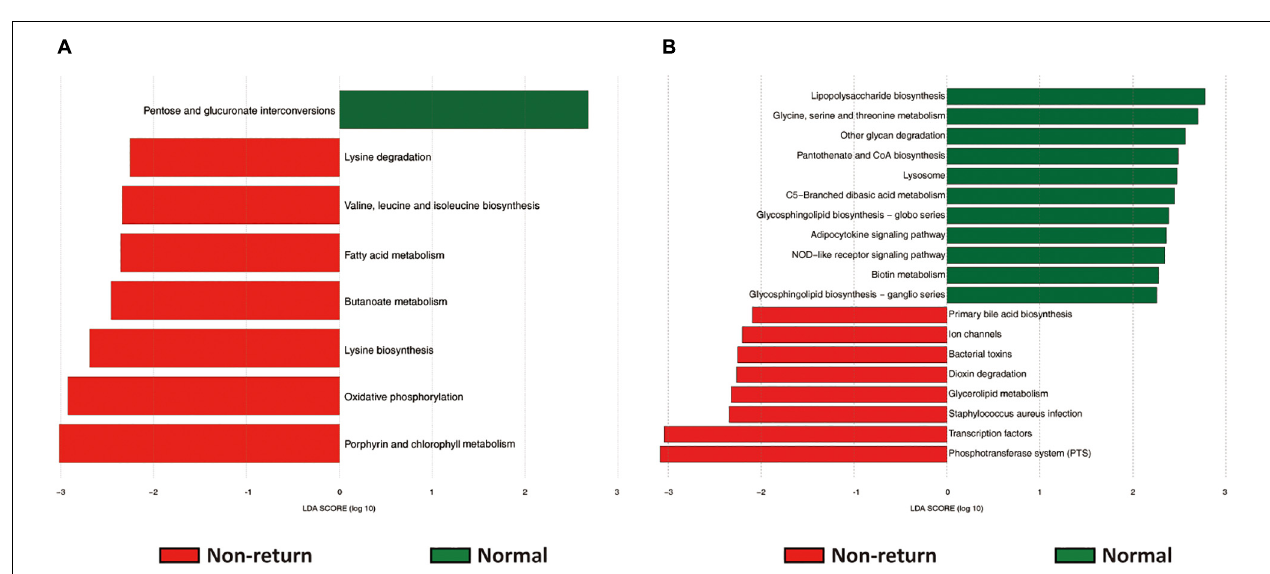
FIGURE 5 | The predicted function capacities of the gut and vaginal microbiome showing different abundances between normal return and non-return sows. Linear discriminant analysis effect size (LEfSe) analysis was used to identify differential KEGG pathways (level 3). (A) Differential KEGG pathways identified in fecal samples (| LDA| score > 2, p < 0.05). (B) Differential KEGG pathways identified in vaginal samples (| LDA| score > 2, p < 0.05).